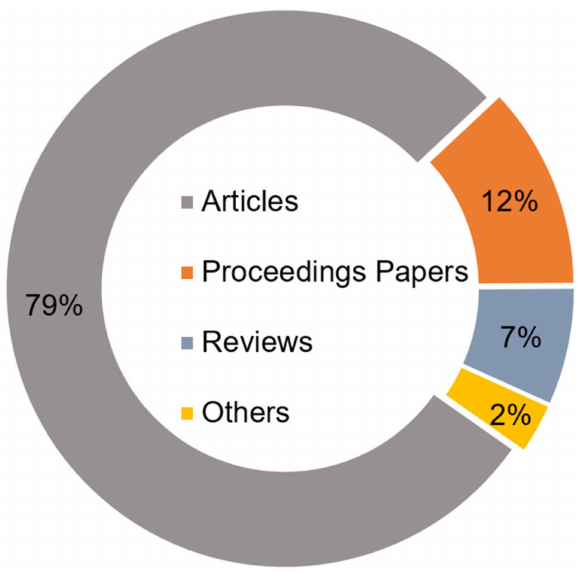
Figure 1. Proportions of each type of Urban food system (UFS)